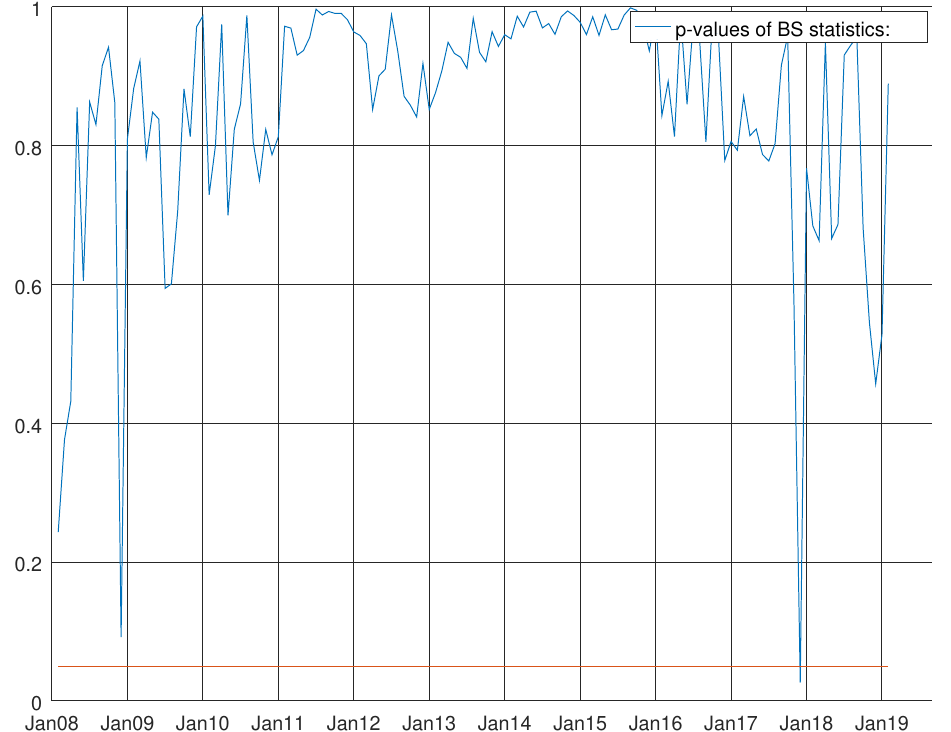
Figure 12. Graph showing the difference between the Bayesian information criterion of the barebone model and the enhanced model for intermediate goods. A negative value means that BB model prevails.